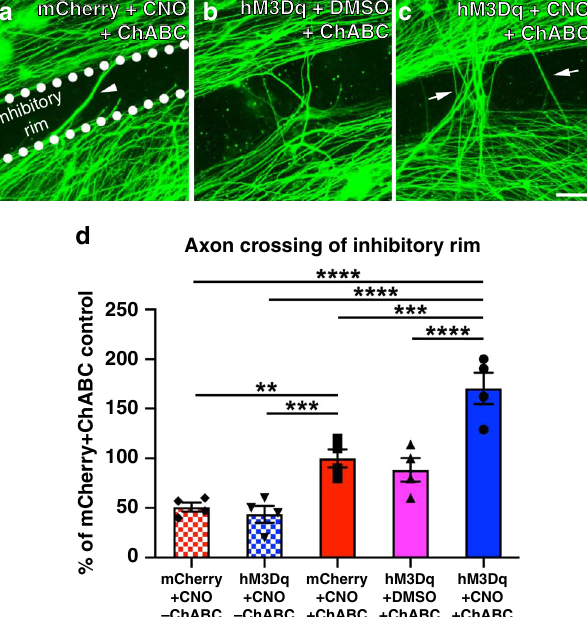
Fig. 1 Chemogenetic DRG neuron activation promotes neurite crossing of a ChABC-treated inhibitory proteoglycan barrier. Representative images of DRG cultures growing on ChABC-treated aggrecan spots are shown in a – c . The inhibitory rim is demarcated in a . Quanti fi cation of the numbers of axons crossing the inhibitory rim is shown in d . Neurons and axons were visualized by β III-tubulin staining (green). Without ChABC, neurons transduced with either AAV-mCherry or -hM3Dq failed to traverse the inhibitory rim. ChABC alone signi fi cantly enhanced axonal growth from absence of CNO. After ChABC digestion of CSPG, some axons from control, mCherry + DRG neurons were able to grow across the inhibitory rim ( a , arrowhead), similar to what we observed when hM3Dq + DRG neurons are cultured in the absence of CNO ( b , d ). CNO-mediated activation of hM3Dq + DRG neurons enabled more neurites to cross the inhibitory rim (arrows in c , d ). More axons crossed the inhibitory rim when CNO-mediated chemogenetic activation of hM3Dq + DRGs was combined with ChABC digestion of the inhibitory substrate. N = 16